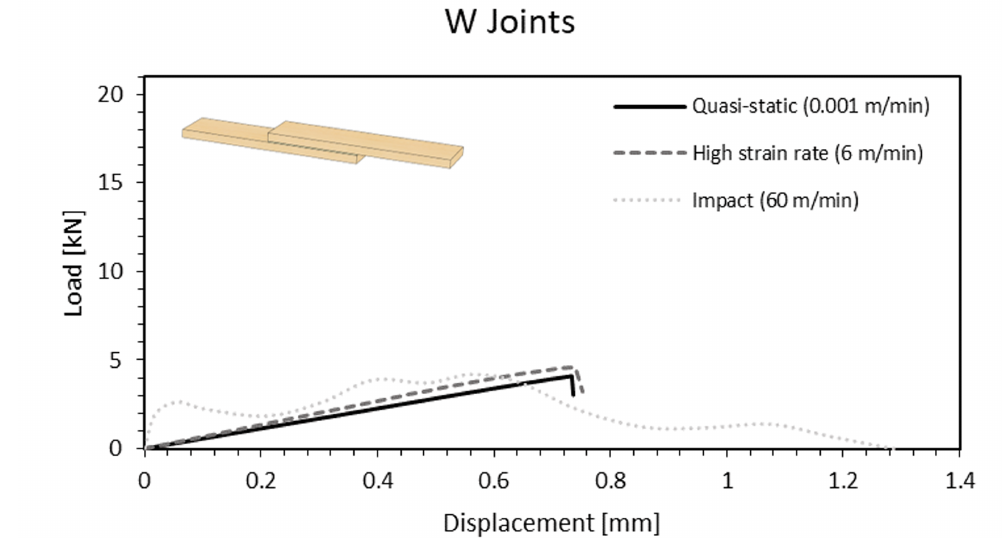
Figure 16. Load-displacement curve of a W joint as a function of the cross-head rate.